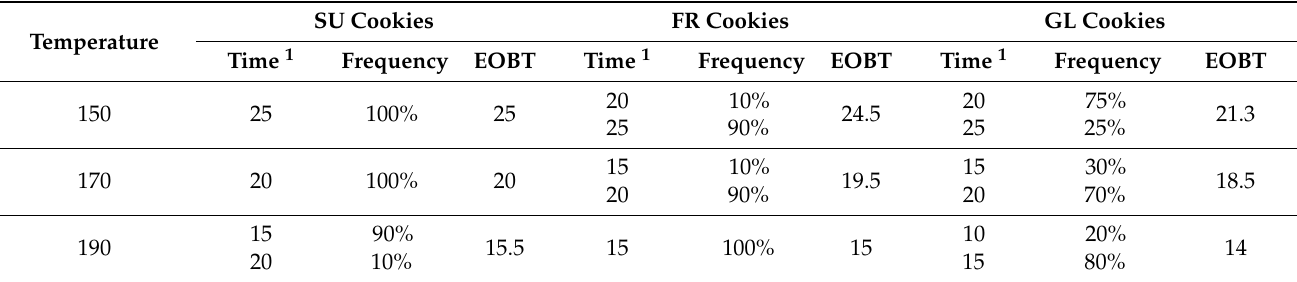
Table 1. Estimated optimal baking time (EOBT) in minutes of cookies produced using different sugars. SU